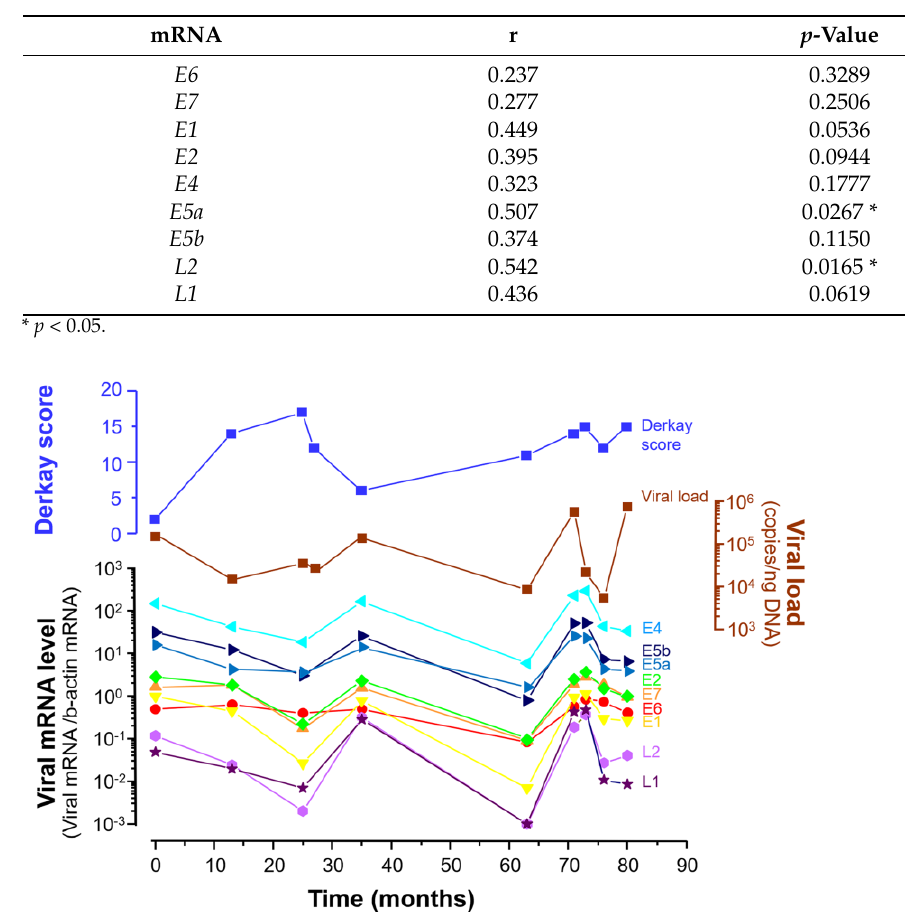
Figure 4. Alteration of mRNA levels, DNA viral load and Derkay score during long-term observa- tion in patient 10. The viral DNA load alteration curve was similar to the mRNA expression curve.